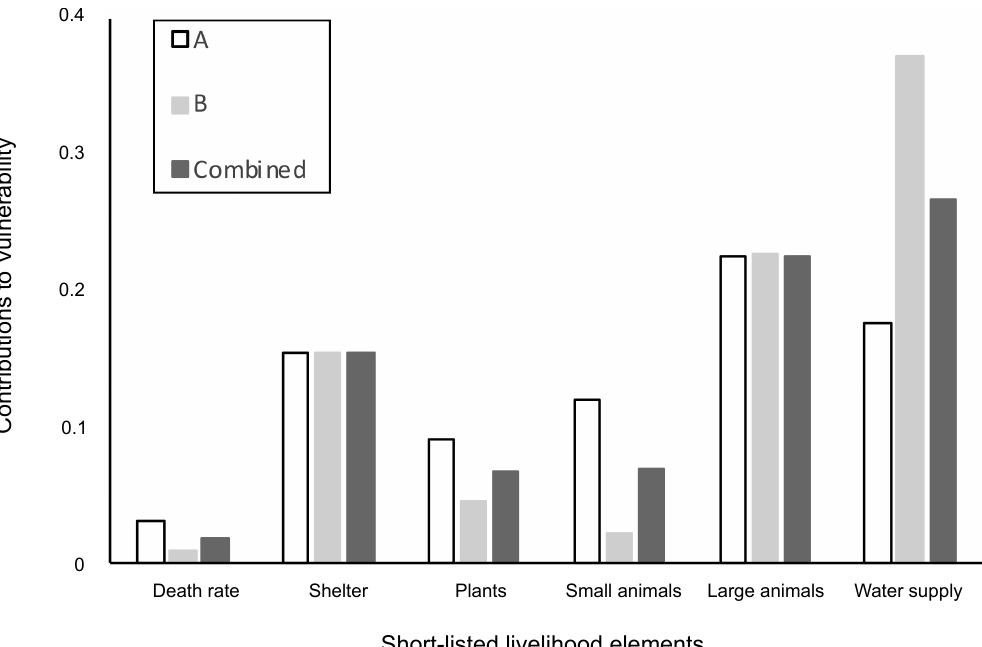
Figure 5: Participant A and B and combined contributions to vulnerability from the six short-listed fields for 20 cm tephra fall.